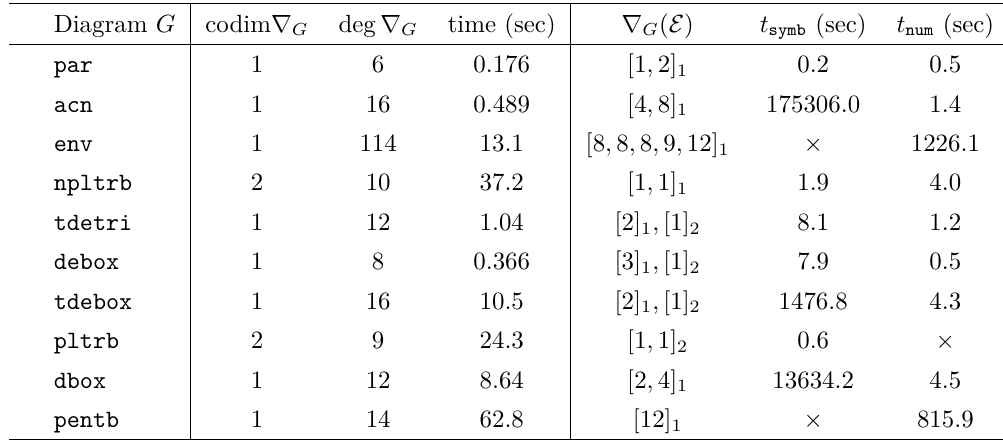
Table 1. Dimension and degree of the Landau discriminants corresponding to the diagrams in figure 1, with computation times. Here E is the linear subspace of P ( K G ) where M i = M and m e = m . For the only five leg diagram G = pentb , we replace the last two lines by LE , s12 , s23 , s34 , s45 , s51 , M , m = substitute5legs ( LE , p , m ; equalM = false